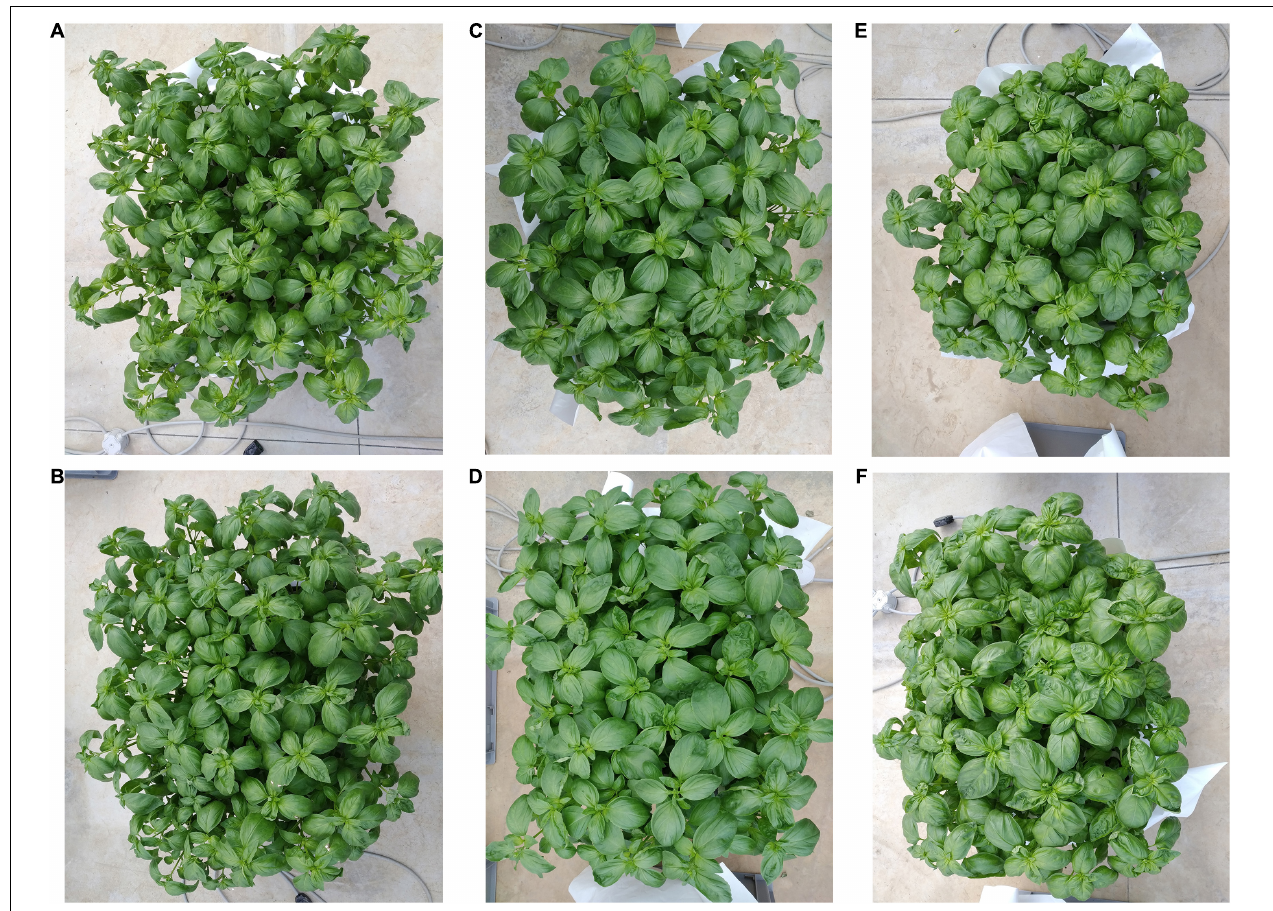
FIGURE 1 | Fresh biomasses of Genovese basil plants at the end of the first harvest at different densities. (A,B) Illustrative pictures of Genovese basil cv. “Aroma 2” at D High and D Low densities. (C,D) Illustrative pictures of Genovese basil cv. “Eleonora” at D High and D Low densities. (E,F) Illustrative pictures of Genovese basil cv. “Italiano Classico” at D High and D Low densities.